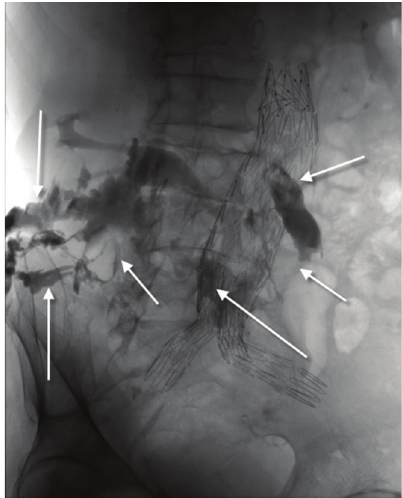
Figure 3: Fistulography: multicanal fistula within the lumbosacral area with contrast accumulation in the small